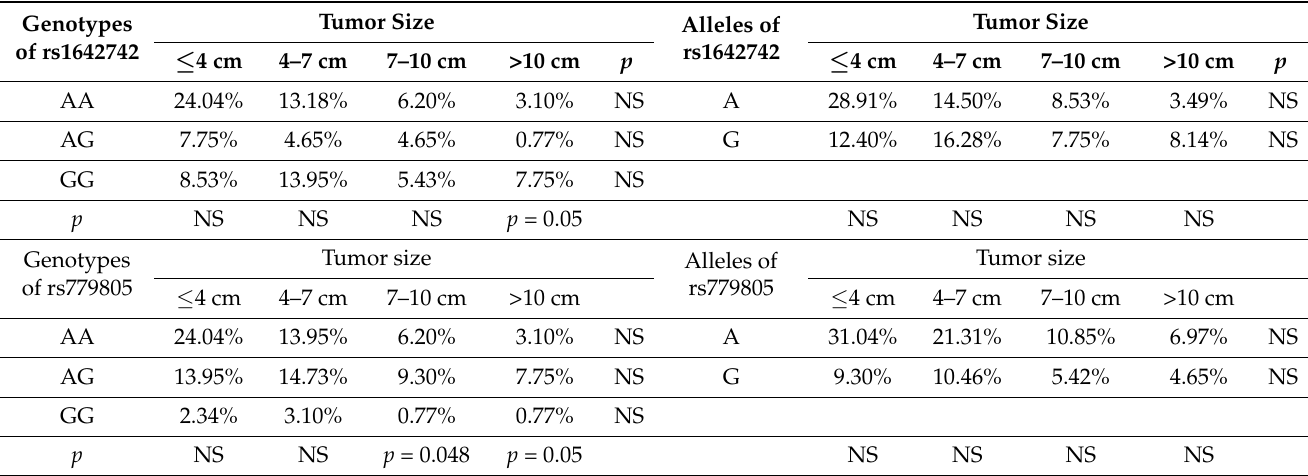
Table 4. Associations of the VHL polymorphisms with largest diameter of